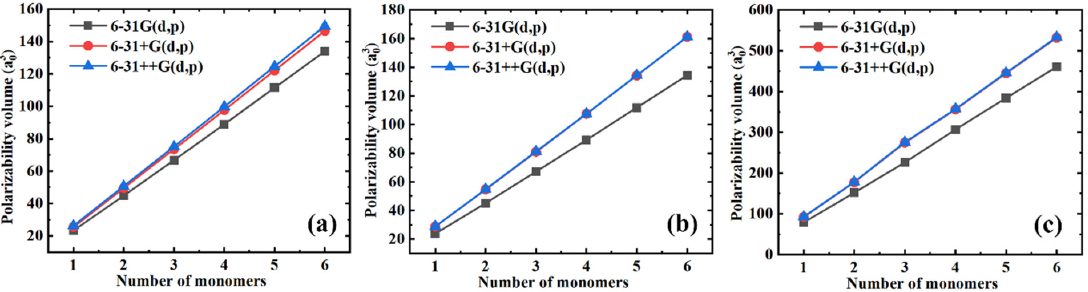
Figure 1. The simulated isotropic polarizability as a function of the number of monomers for different polymer materials with different basis sets. ( a ) PE; ( b ) PTFE; and ( c ) PS.